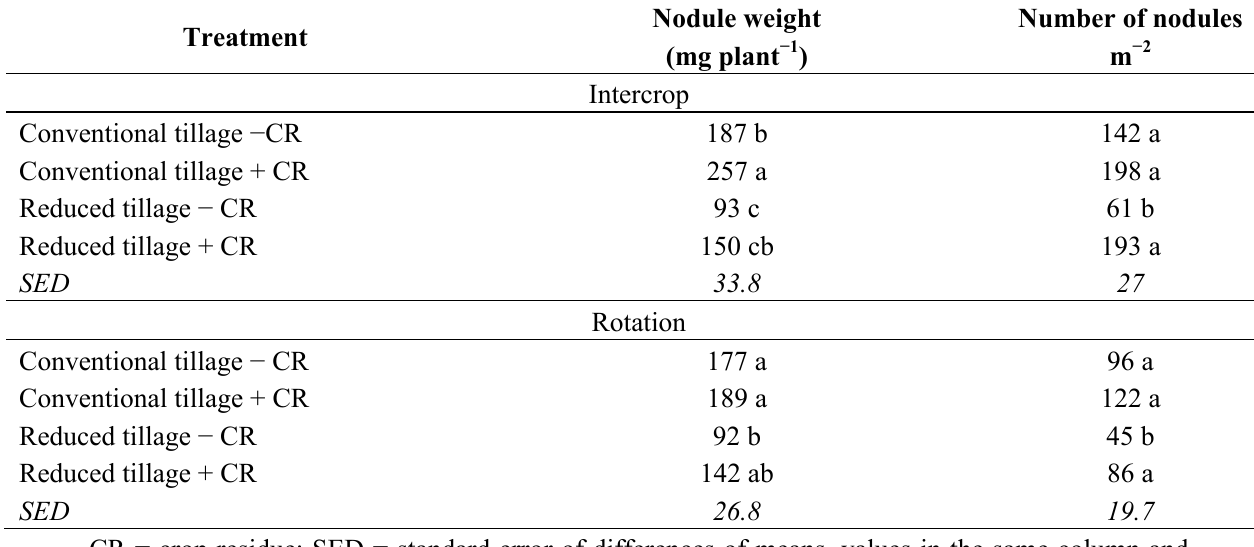
Table 1. Average nodule number and weight (kg ha − 1 ) at podding as observed over four seasons between 2003 and 2005 in Nyabeda, western